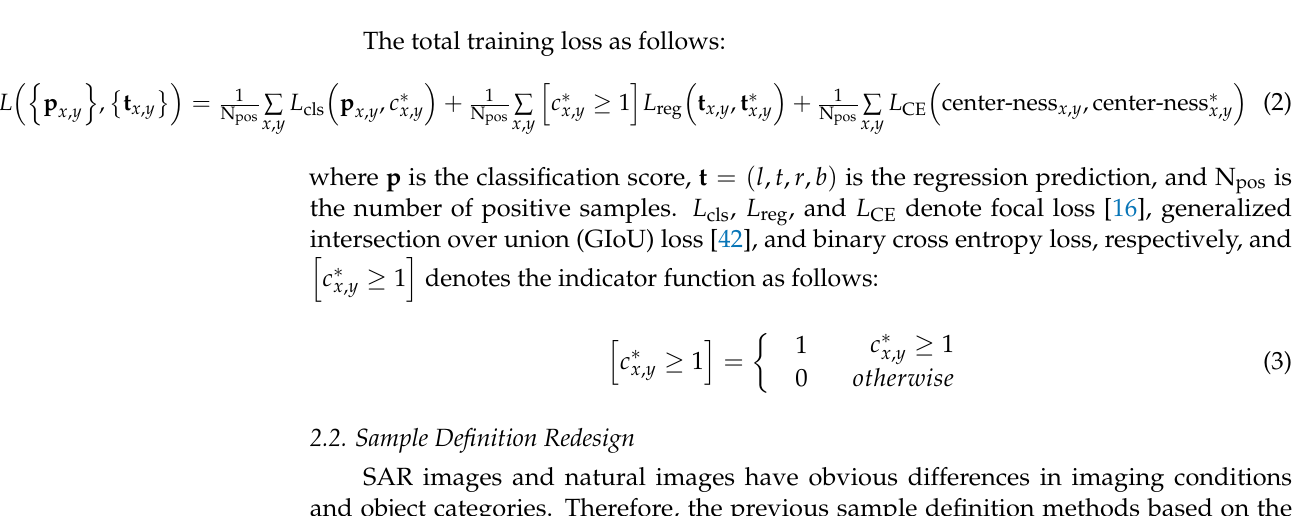
Figure 3. The architecture of FCOS. C denotes the number of classes.